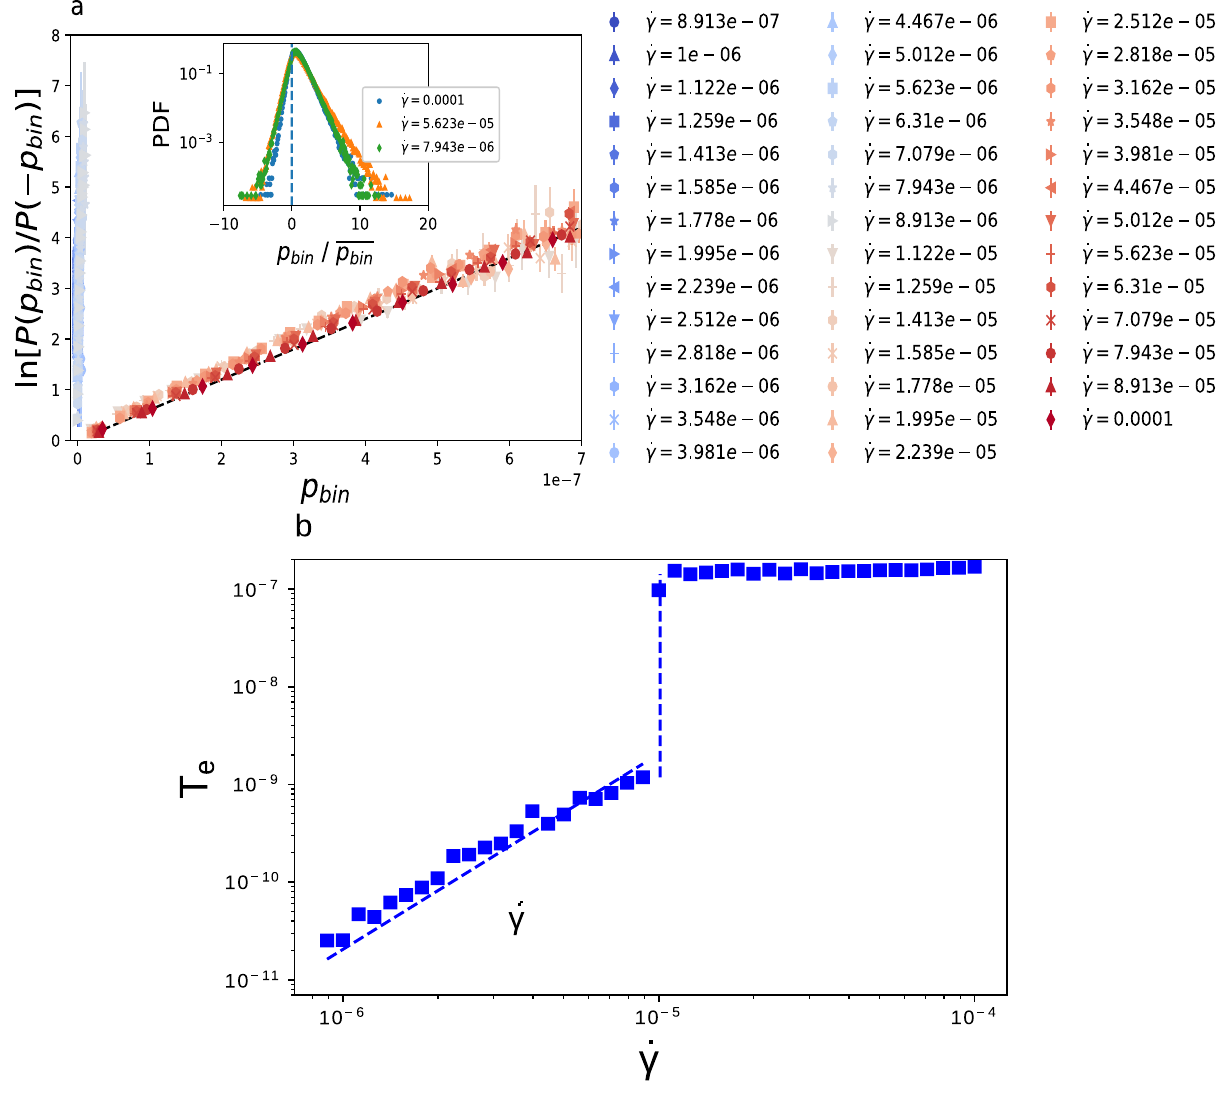
Fig. 2 Fluctuation relation of power and the resulting effective temperature. a The inset shows the probability distribution function (PDF) of injected power into a bin versus the power divided by the mean power for various global shear rates. The system is divided into narrow rectangular bins along the shearing direction. It displays a bell-type distribution with exponential tails. In the main panel, we examine the fl uctuation relation proposed in Eq. (2), which is successfully veri fi ed by our data. In this equation, PDF of power, P ( p bin ), is divided by that of negative power, P ( − p bin ). Blue and red symbols correspond to regimes below and above thickening, respectively. The dashed line is a guide for eye to show the expected linear dependence. b The effective temperature T e , derived from the fl uctuation relation, as a function of the shear rate _ γ is plotted. Bagnold behavior is found in the fl uid branch, which crosses over to a rate-independent behavior in the thickened branch, in accordance with the rheology (Supplementary Fig. 1a). The effective temperature increases almost two orders of magnitude after thickening. The dashed line is a guide for eye to show the Bagnold scaling, (cid:3) _ γ 2 , in the phase below the thickening transition. Error bars are smaller than symbols. The packing fraction is ϕ = 0.81, and the number of particles is N = 16,384. We create an ensemble by storing con fi guration of the system at every strain difference of one particle diameter. In total, we average over 2560 con fi